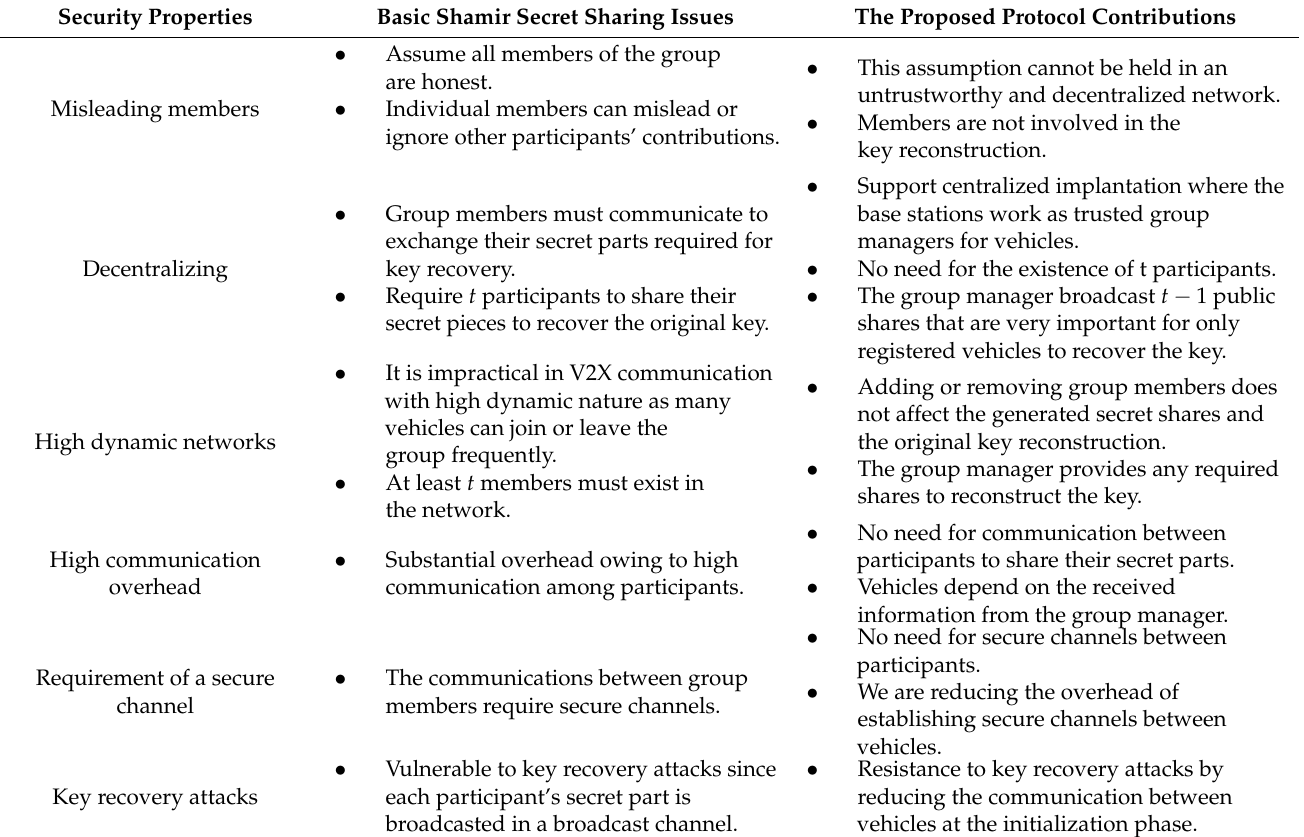
Table 1. The proposed protocol contributions over the basic Shamir secret